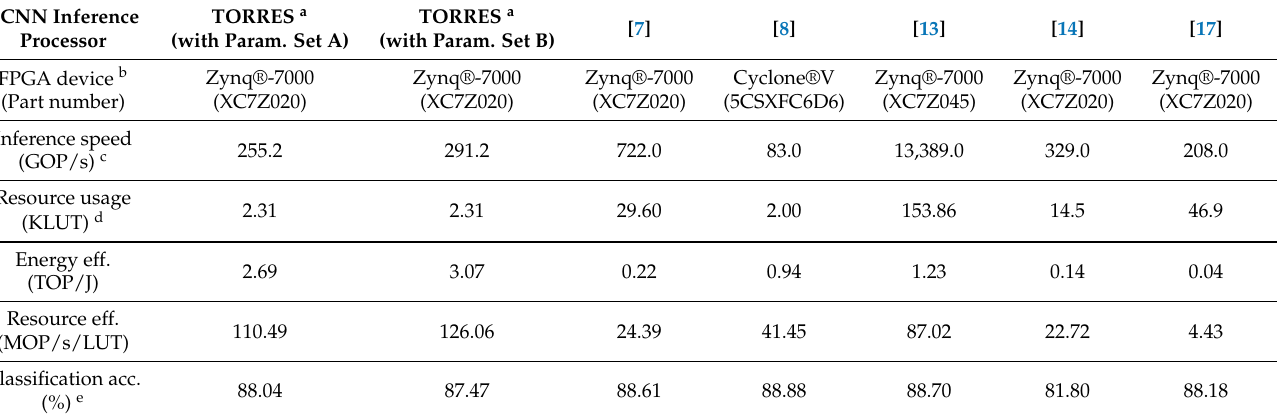
Table 3. Implementation results of the BCNN inference processors in